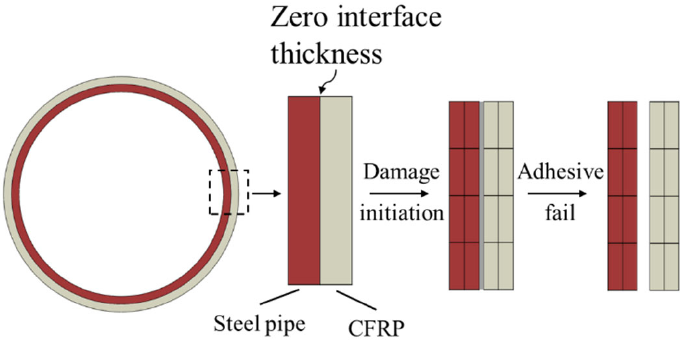
Figure 4. Schematic diagram of zero ‐ thickness adhesive layer.